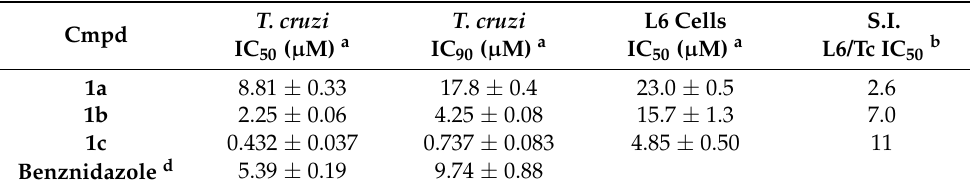
Table 2. Anti- T. cruzi screening of derivatives 1a – c